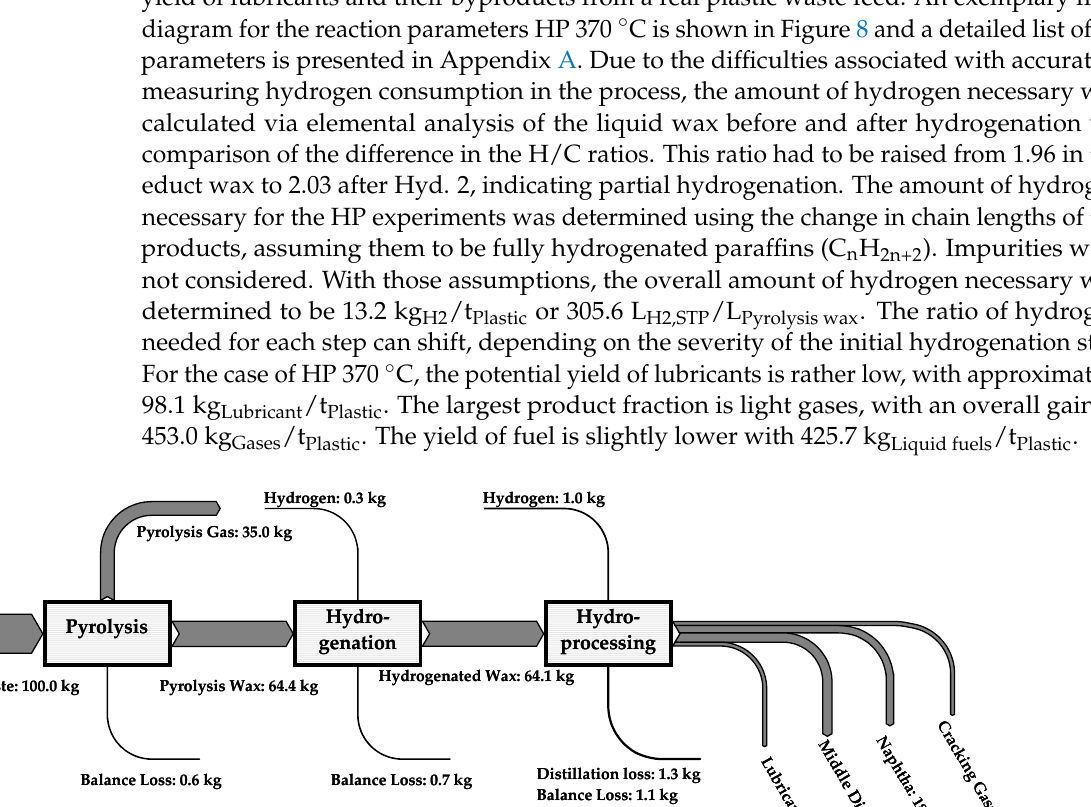
PW Lube Figure 9. Cloud points of FT and PW lubricant over reaction temperatures at p = 100 bar, V ̇ wax = 0.42 mL/min.